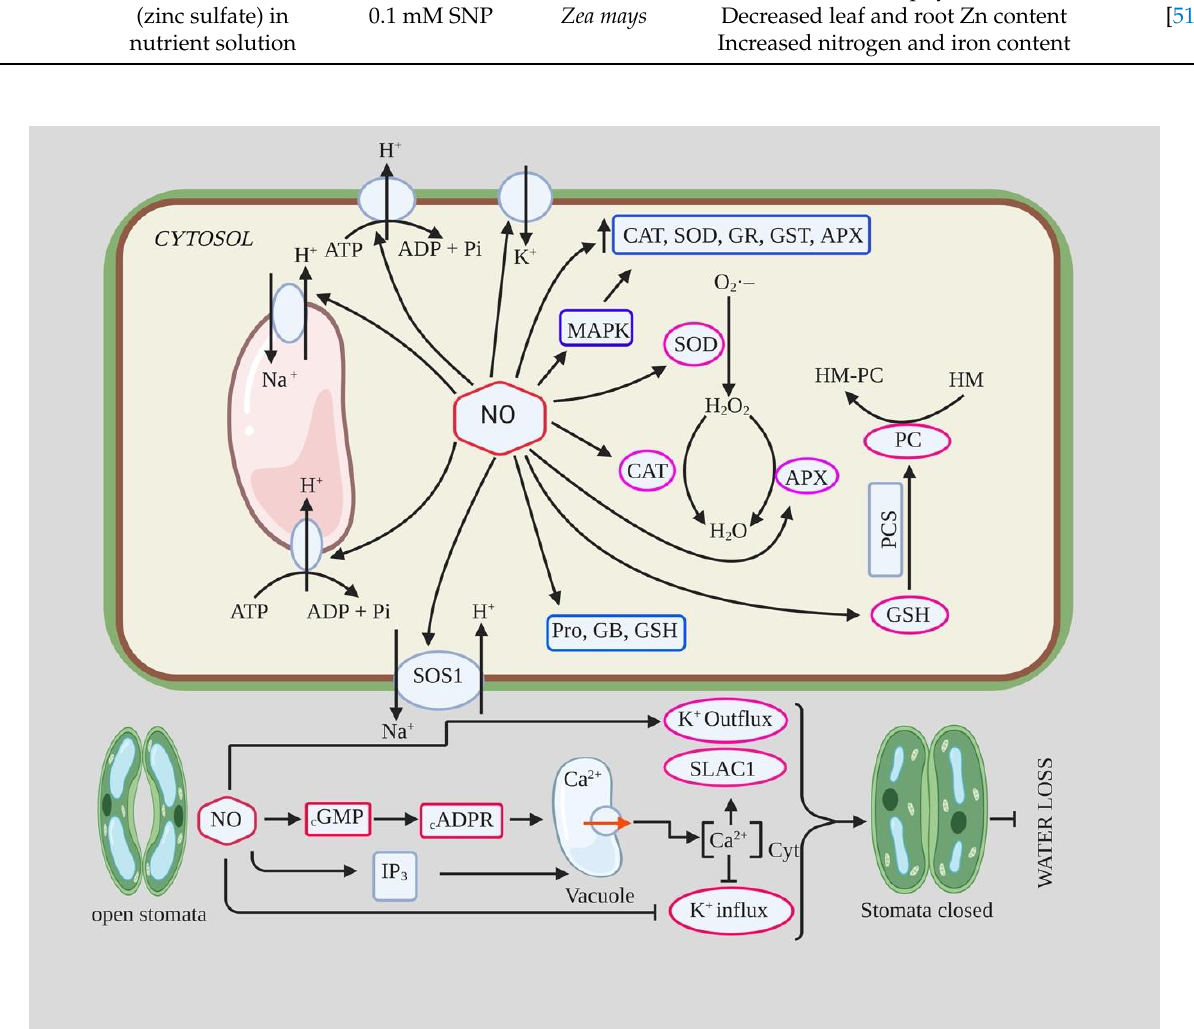
Figure 1. Schematic diagram showing the functional roles played by nitric oxide (NO) in plants exposed to drought, heavy metal, and salinity stress. NO enhances the activity of Na + /H + antiporters on the vacuole membrane as well as the plasma membrane, such as SOS1, which helps in the removal of excess Na + from cell cytoplasm. It also facilitates K + ion entry into cells to maintain a balanced Na + /K + ratio during salinity stress. NO up-regulates the activity of antioxidant enzymes, thiols, and compatible osmolytes, which protect the plants against salinity, drought, and HM stress by preventing membrane damage, ion and metal toxicity, osmotic stress, lipid peroxidation, and excess ROS production. It is involved in phytochelatin (PC) biosynthesis via GSH with the help of enzymes PCS; these PCs then help in sequestration of excess metals. NO also increases cytosolic free Ca 2+ through cGMP and cADPR up-regulation. High cytosolic Ca 2+ causes stomatal closure due to the activation of outward anion channels such as SLAC1 and inhibition of K + inward channels. This helps in opti- mizing water usage during drought stress. Pro: Proline; GSH: Glutathione; GB: Glycine betaine; PCS: Phytochelatin syn- thase; HM-PC: Heavy metal-Phytochelatin complex; cADPR: Cyclic ADP-Ribose; cGMP: Cyclic GMP; CAT: Catalase; SOD: Superoxide dismutase; GR: Glutathione reductase; GST: Glutathione S-transferase; APX: Ascorbate peroxidase; IP 3 : Inositol triphosphate (it acts as a second messenger); Cyt: Cytosolic. Made with Biorender.com (Accessed on 3 September 2021).